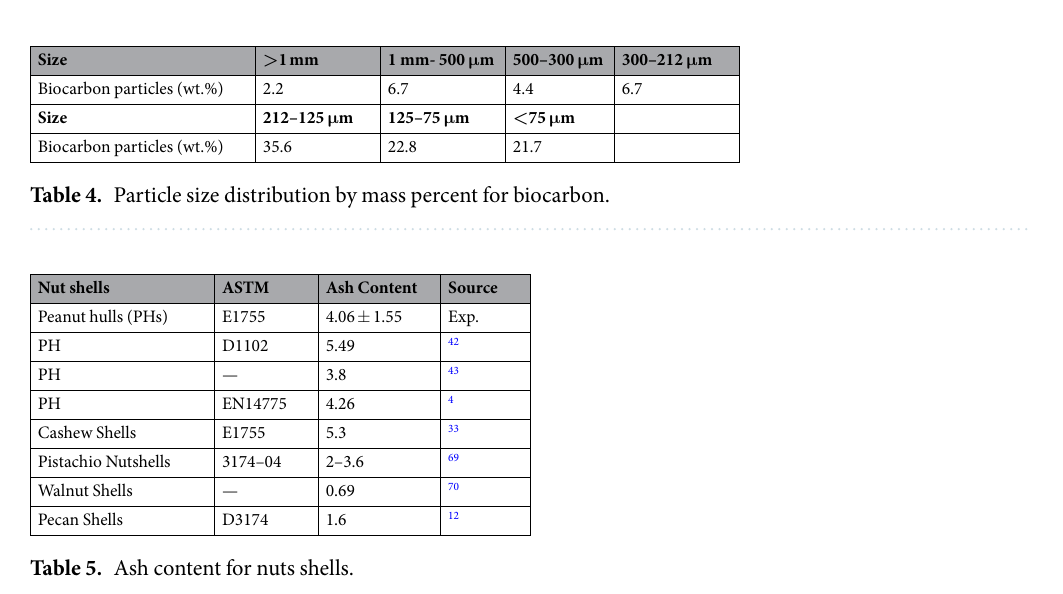
Figure 3. SEM images ( a ) peanut hulls and ( b ) 500 °C peanut hull biocarbon.